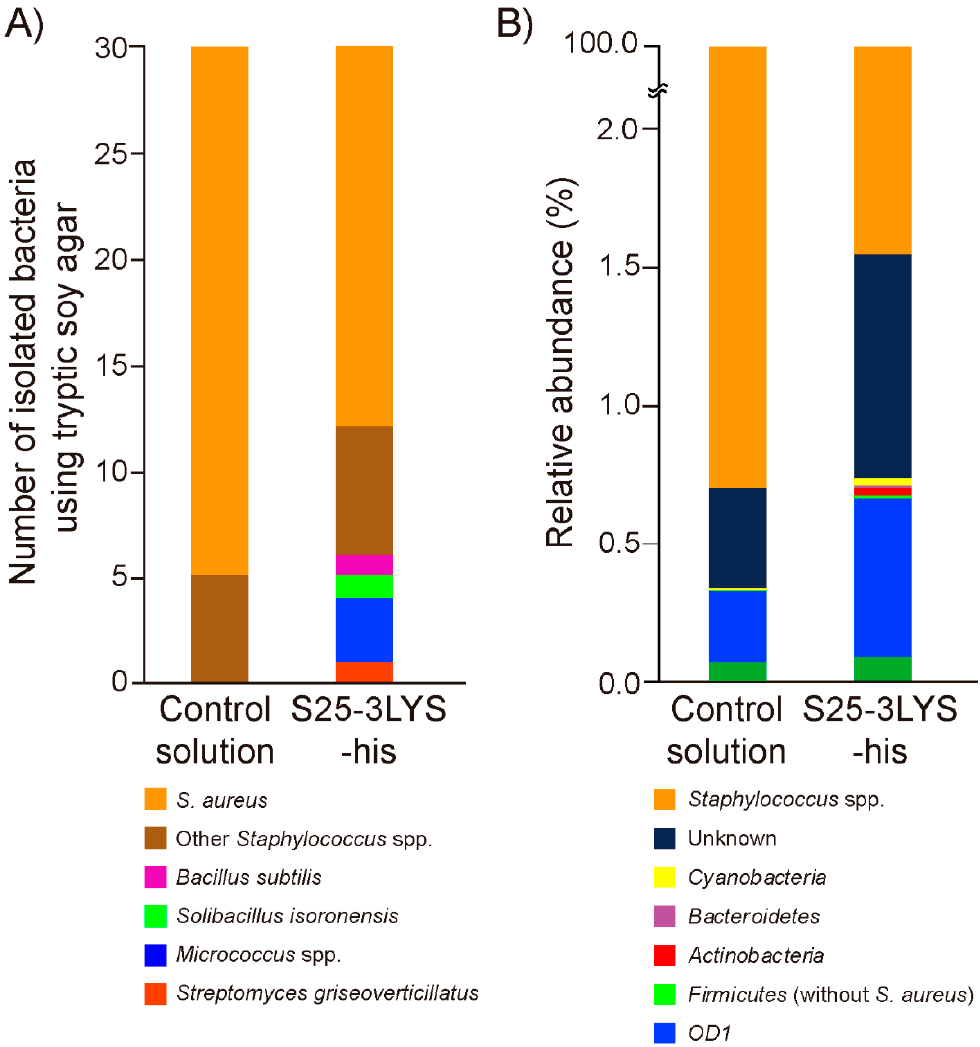
Figure 3. Taxonomical abundance of the microbiome on mouse skin treated with the control solution or S25-3LYS-his, as determined by ( A ) culture methods and ( B ) 16S rRNA gene amplicon analysis. At the bottom, bacterial taxonomical assignments are shown. Using the culture method, 30 bacteria were isolated from the skin ( N = 3) for each treatment group, then phylogenetically classified based on their 16S rRNA gene sequence. Using 16S rRNA gene amplicon analysis, the average taxonomical abundance of the skin microbiome ( N = 3) for each treatment group is shown. The phylum taxonomical level is shown. For data analysis, a total of 182,317 reads were used, with each sample comprising 30,386.2 ± 5886.1 reads (mean ± SD), of which 27,700 reads in each sample were rarefied.